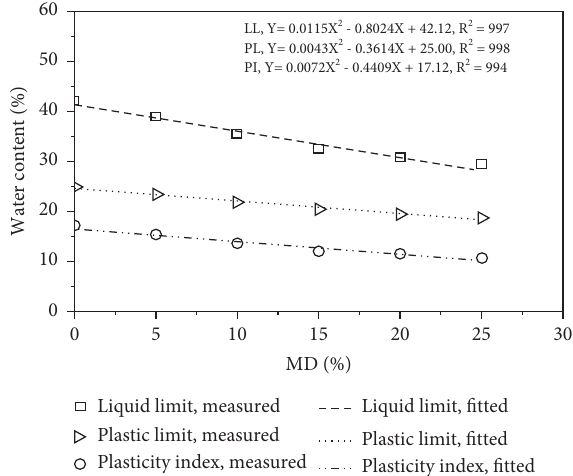
Figure 5: Variation of Atterberg’s limits with different percentages of MD.